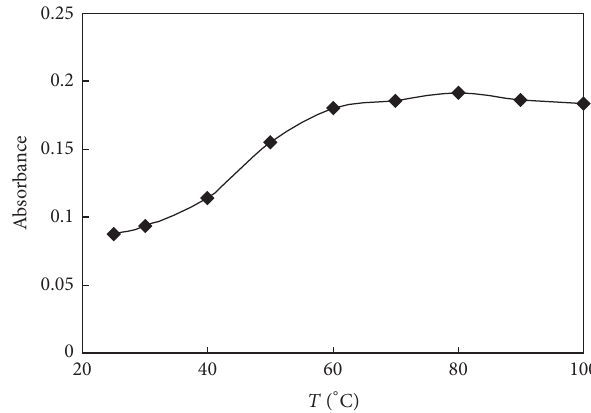
F 6: Effect of equilibration temperature on the absorbance of Co(II). Conditions: equilibration time of 20min, centrifugation for 5 min at 1500rpm.